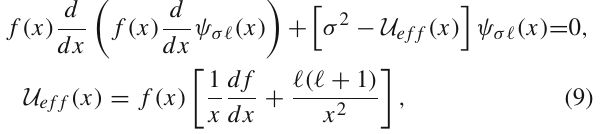
Fig. 1 Plot of the function f ( x ) given by (10). The solid line ( μ e = 1 . 904) represents the scenario of an extreme black hole where the event and Cauchy horizons coalesce together at the common value x 0 = 1 . 587. The dotted line ( μ = 2 . 5) corresponds to the case of a non extreme black hole while the dashed line ( μ = 1 . 5) describes a gravitational object characterized by a regular de Sitter core around x = 0